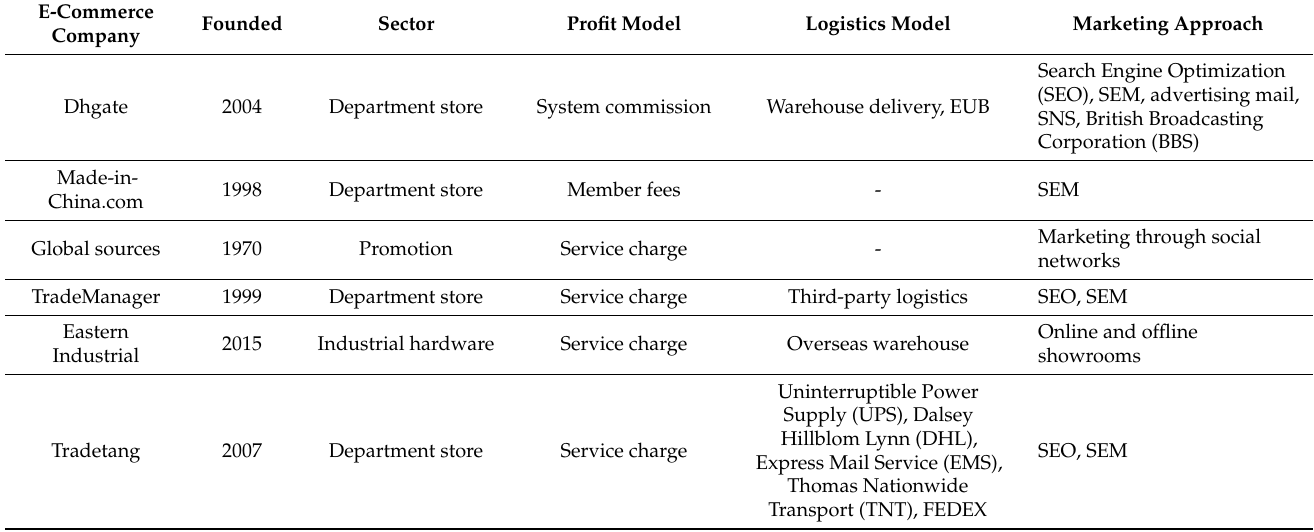
Table 3. Overview of Chinese companies with cross-border B2B operating